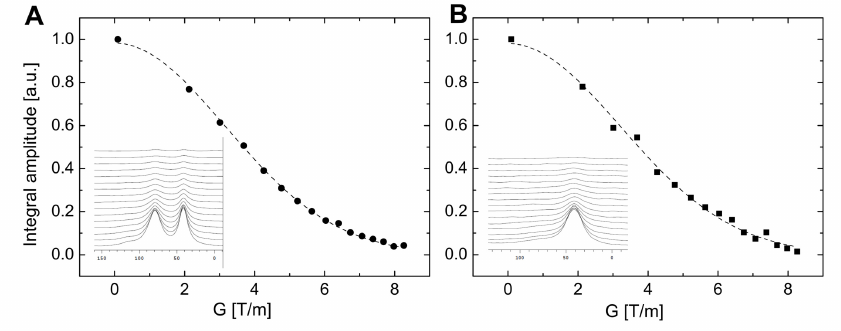
Figure 4. The 2 H PGSE spin echo attenuation obtained at 303 K for SDS- d 25 ( A ) and DPC- d 38 ( B ) micelles contained the TM4 peptide. The 2 H 1D NMR spectra used for extract D tr values are presented as